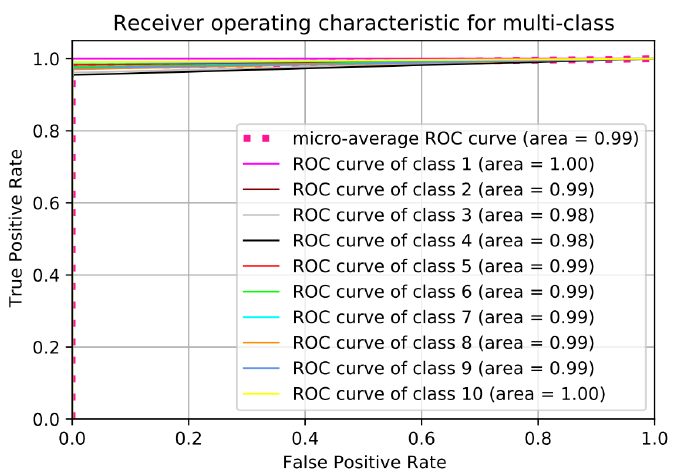
Figure 13. Receiver Operating Characteristic (ROC) curve for 10 classes